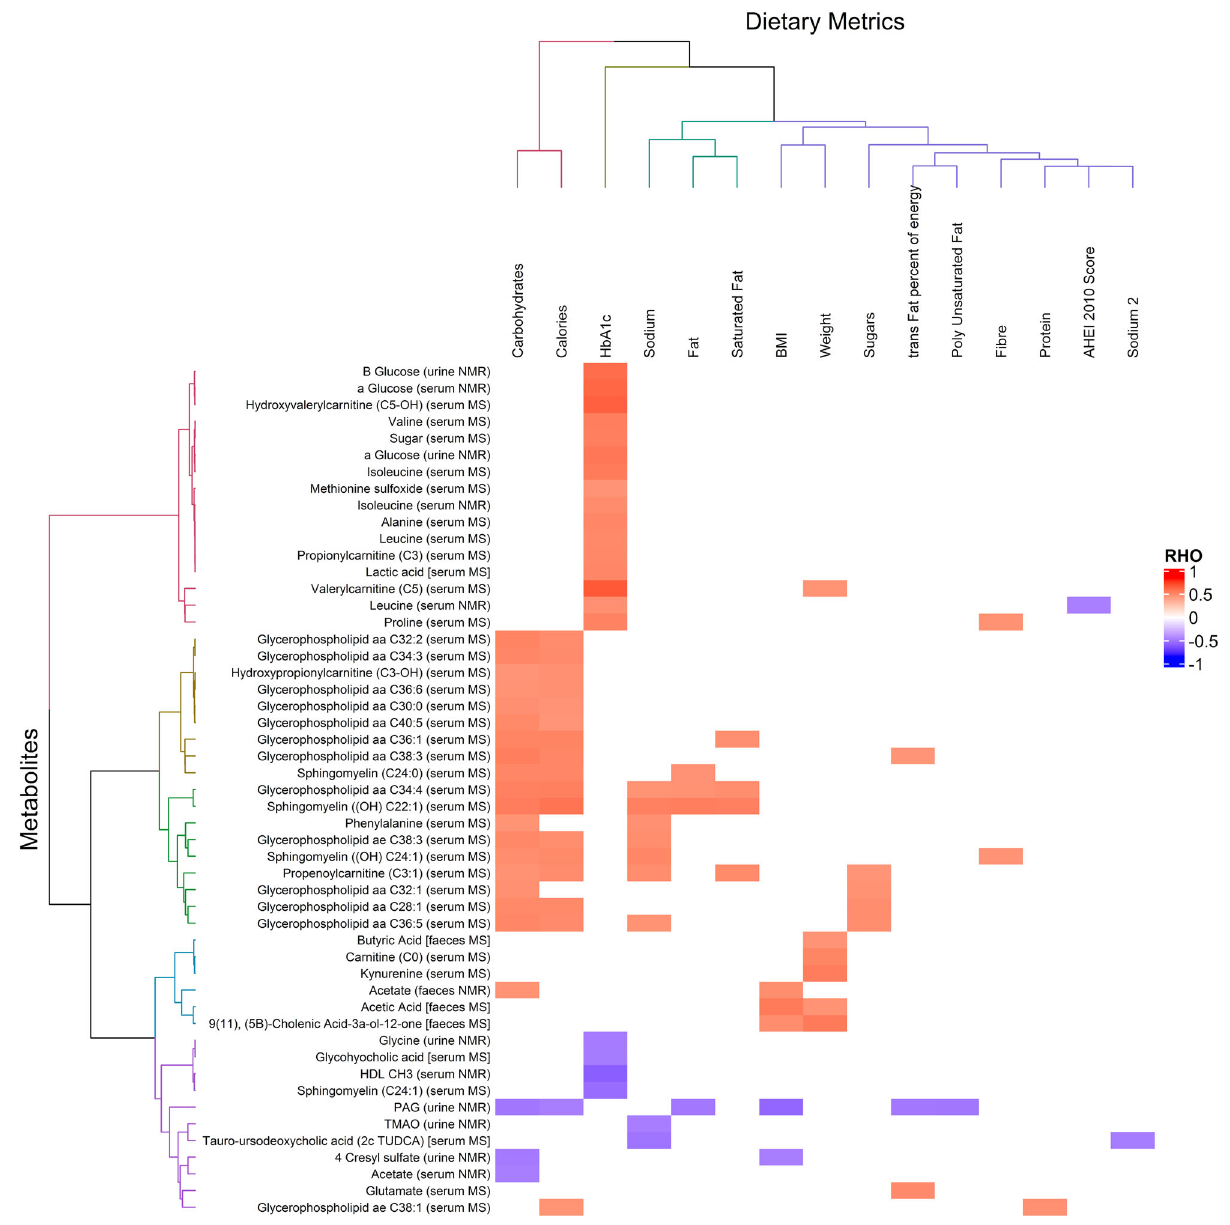
Fig. 8 Metabolite — dietary intake correlations. Signi fi cant Spearman ’ s correlations (pFDR < 0.05) between measured metabolites and dietary intake are shown and shaded according to strength of correlation coef fi cient (Rho), ( n = 65). The corresponding bio fl uid (urine, serum and faeces) of each measured metabolite is